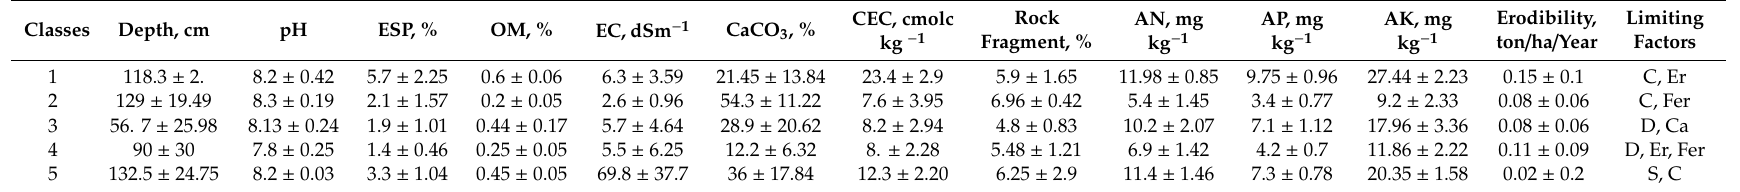
Table 6. The main statistical characteristics of the soil properties in five